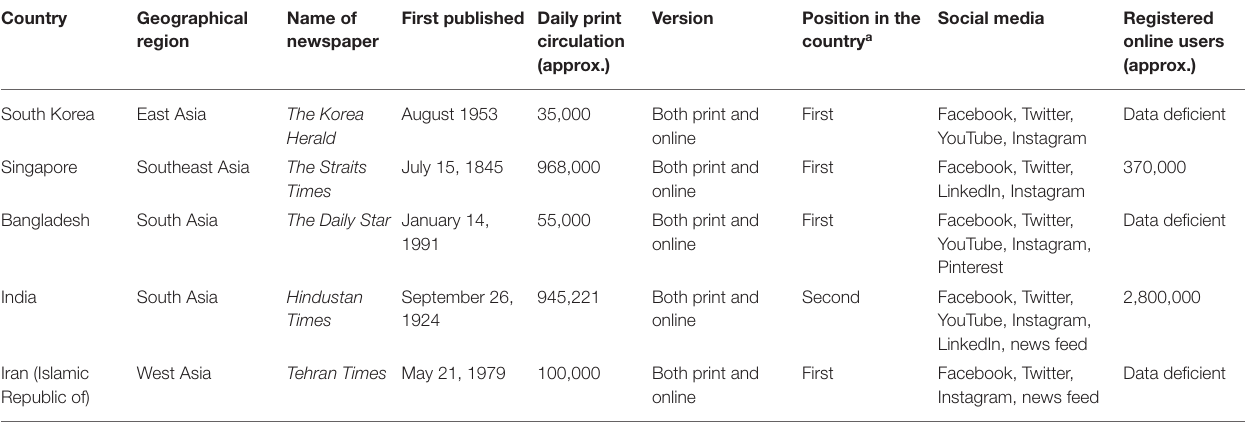
TABLE 3 | Details of study areas and English-language dailies searched in this study.